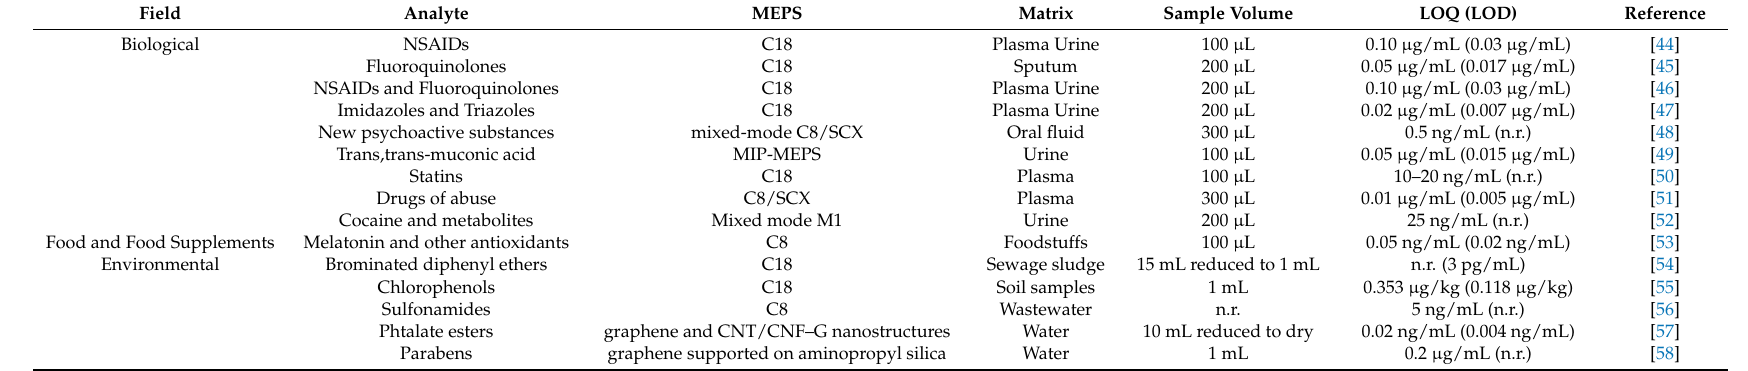
Table 1. Some recent MEPS applications (2012–2017, not previously reviewed) [39,43] in different fields, and the performances obtained when applying this